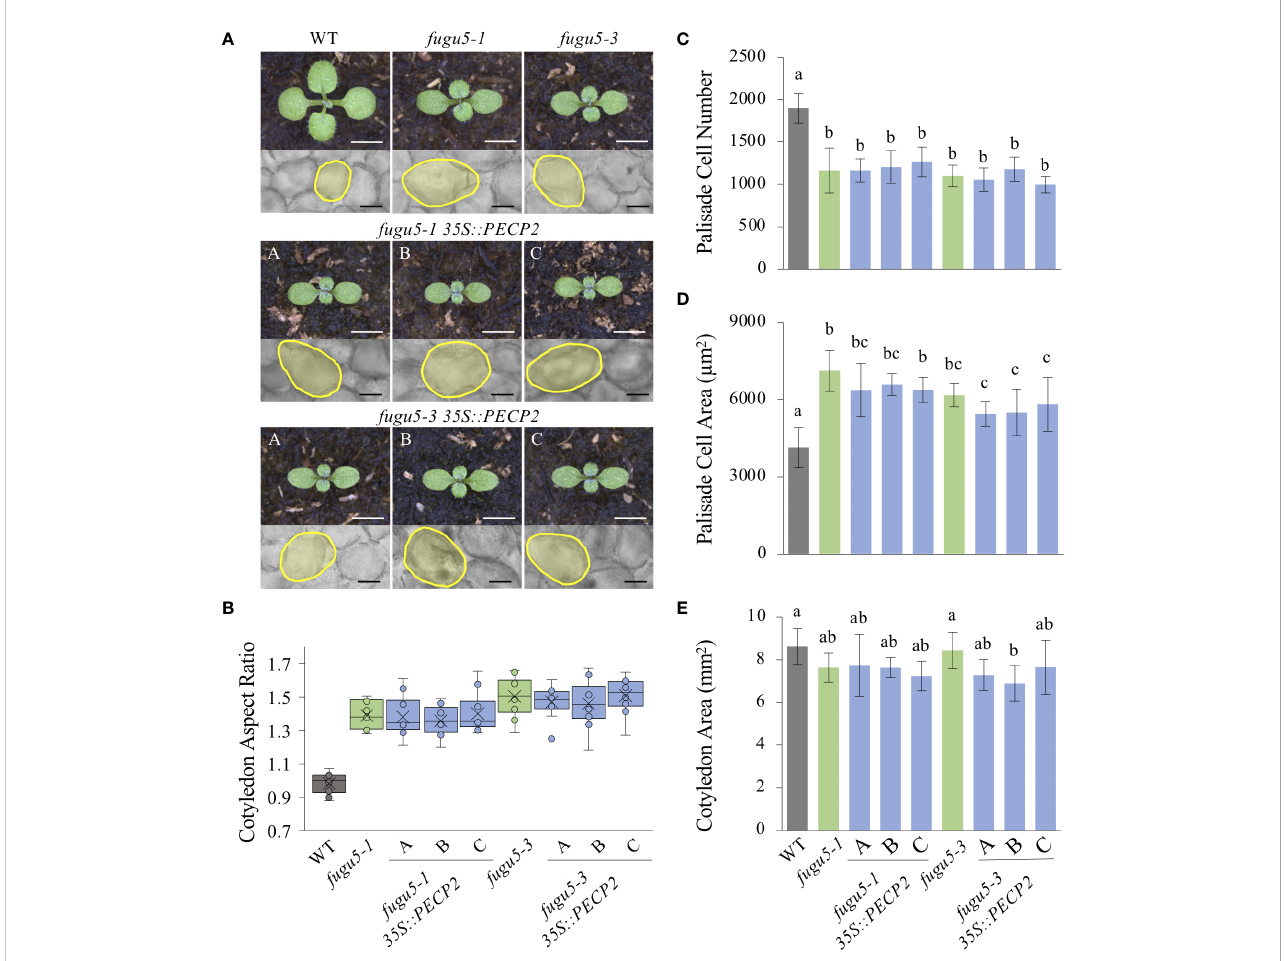
FIGURE 5 Quanti fi cation of cotyledon morphological and cellular phenotypes of PECP2 overexpressing lines in the fugu5 background. (A) Gross morphology of the indicated genotypes (above), grown on rockwool for 10 DAS. Scale bar = 2 mm. Micrographs of palisade tissue cells from cleared cotyledons of the WT, fugu5-1 , fugu5-3 , fugu5-1 35S::PECP2 , and fugu5-3 35S::PECP2 lines (below), at 25 DAS. Scale bar = 50 µm. (B) Box plots of cotyledon aspect ratio at 25 DAS ( n = 8 cotyledons). The lower and upper portions of the boxes are the fi rst and third quartiles, respectively, and the dividing line is the median. Dots represent each value. (C – E) Numbers of subepidermal palisade tissue cells (C) , their average sizes (D) , and the average sizes of each cotyledon (E) at 25 DAS. Data are means ± SD ( n = 160 cells from eight different cotyledons). Each character represents a signi fi cant difference at P < 0.05 (Tukey ’ s HSD test). DAS, days after seed